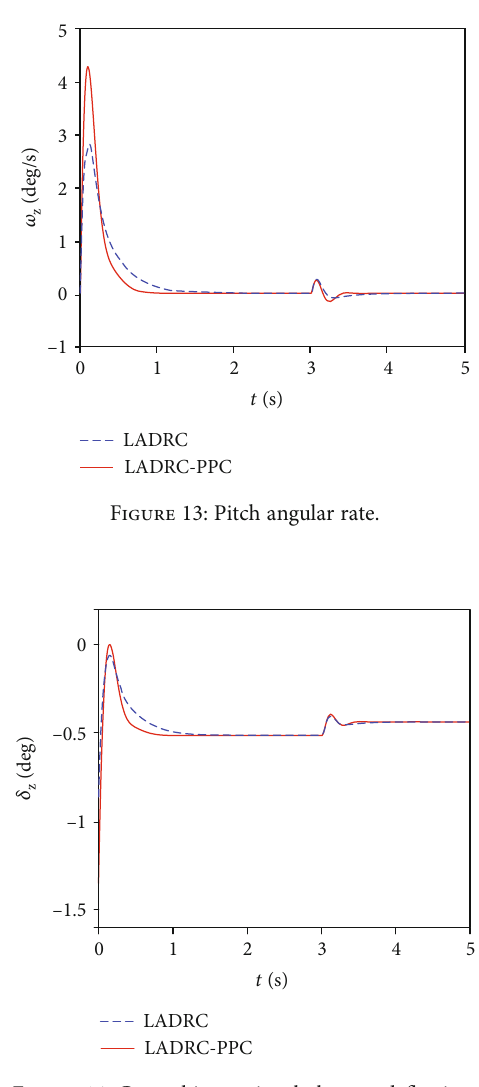
Figure 14: Control input signal-elevator de fl ection.